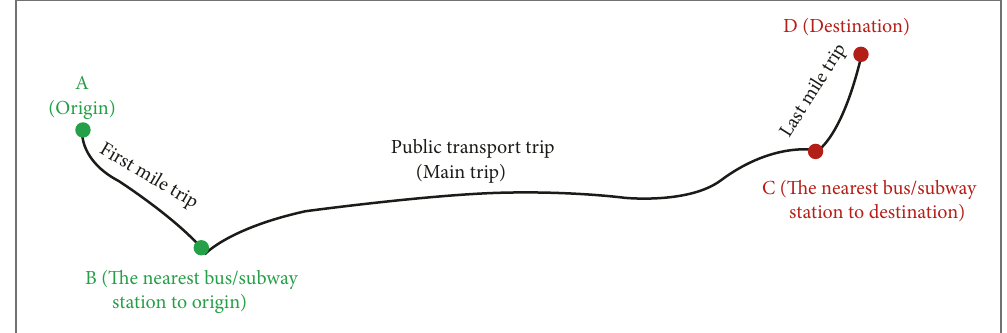
Figure 2: The sketch map of an entire